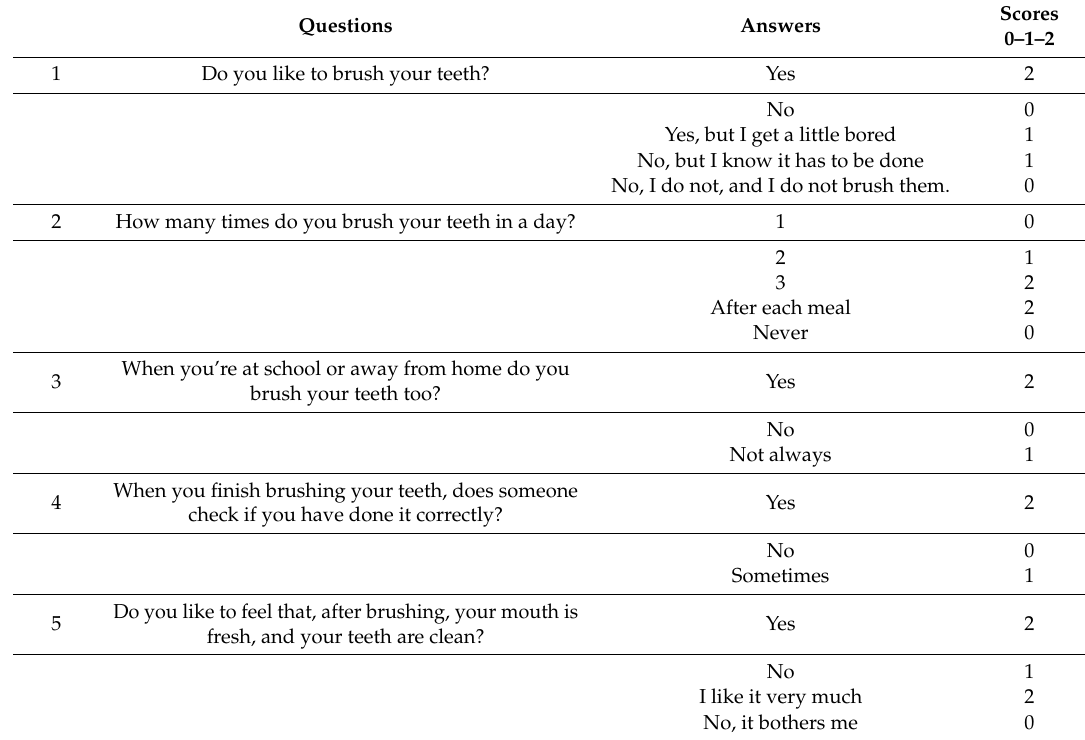
Table A1. Questionnaire on home oral hygiene attitude (AOH index) and scores assigned to the